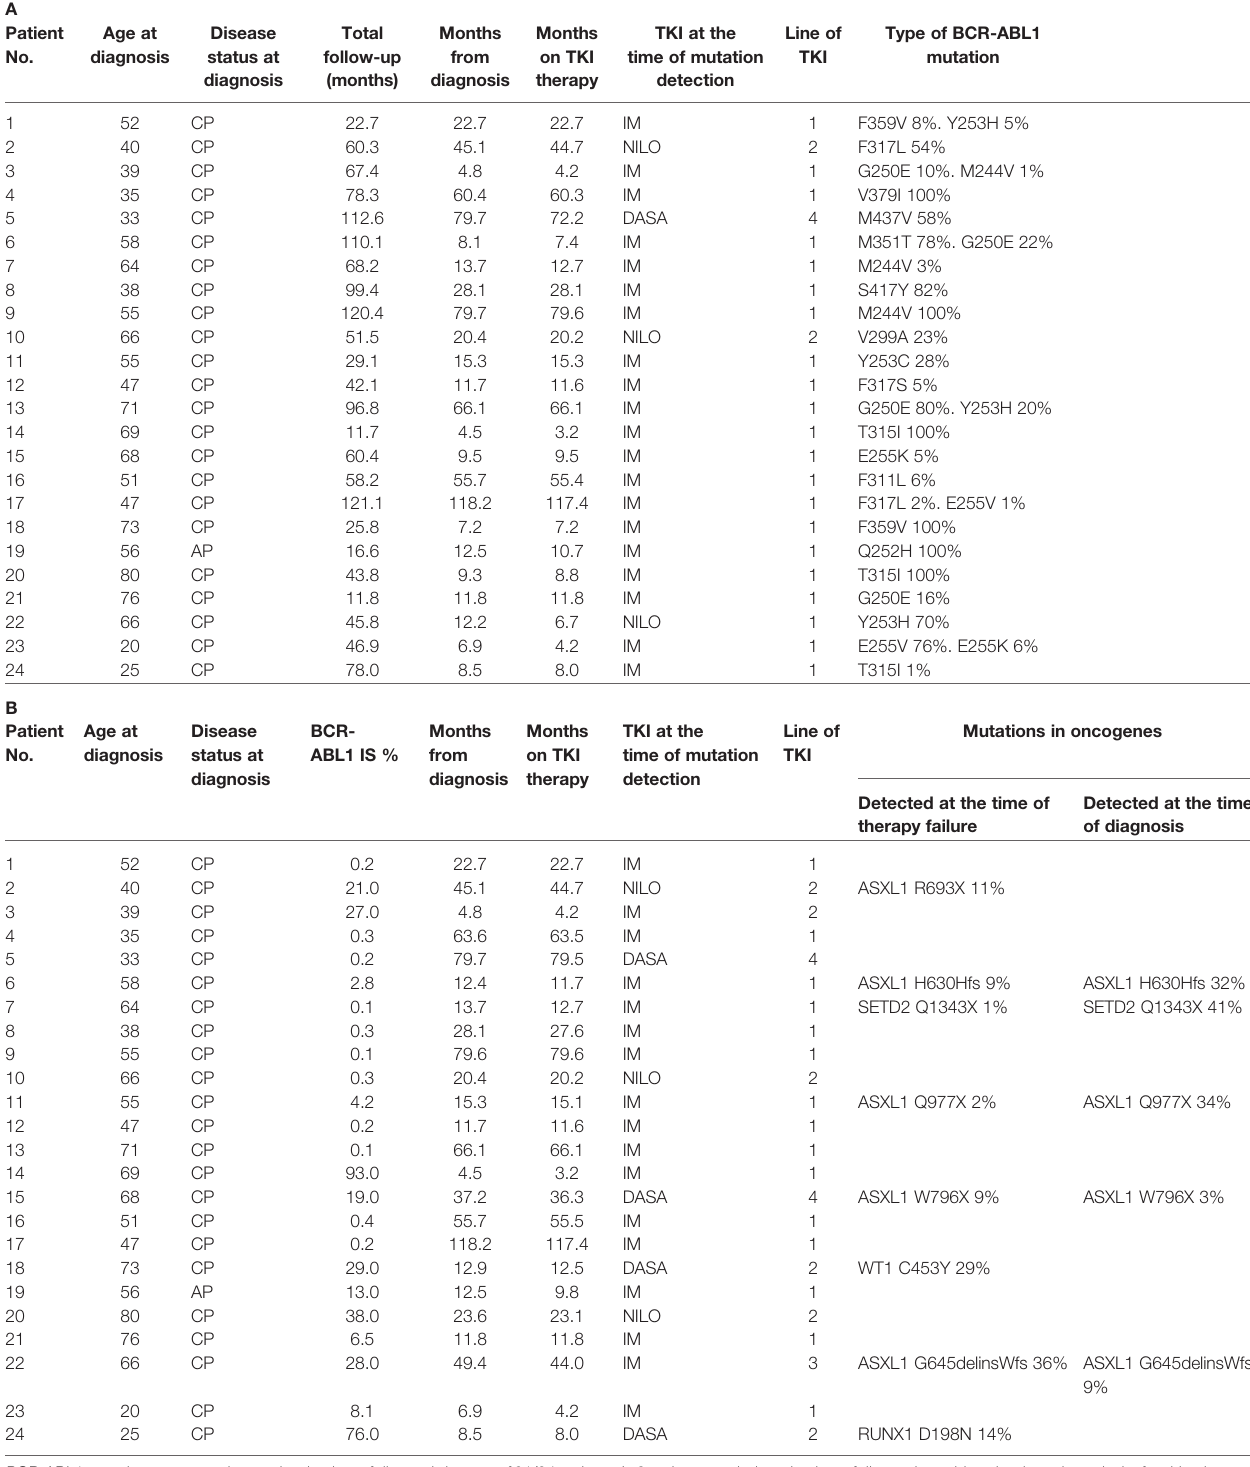
TABLE 1 | CML patients characteristics who failed to TKI with detected BCR-ABL1 mutations (A) BCR-ABL1 mutation detection at the time of therapy failure. A Patient